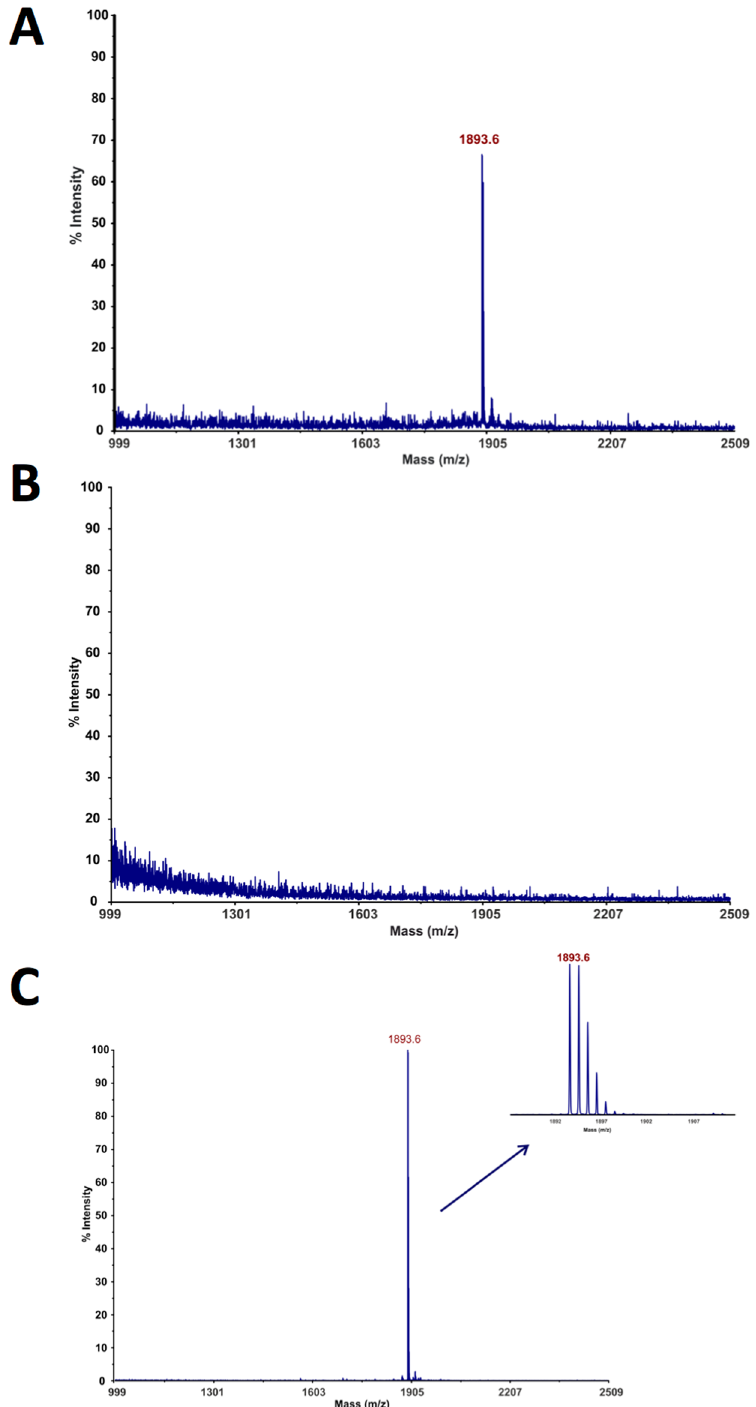
Fig 2. Microcolumn affinity test. Microcolumn affinity test results for bindingof HVEM(23–39) fragment to BTLA: ( A) supernatant,( B) last wash and ( C) elution fractions. The MS measurements were done with the use of MALDI TOF/TOF 5800 (ABSciex, Germany). As a matrix α -cyano-4-hydroxycinnamic acid (CHCA, 10 mg/ml, Sigma-Aldrich) was used. The measurements were done in reflector positive mass mode with previous mass calibrationwith commercial standard peptidemixture (The Peptide Mass Standards Kit for Calibration of AB SCIEX MALDI-TOF ™ Instruments).